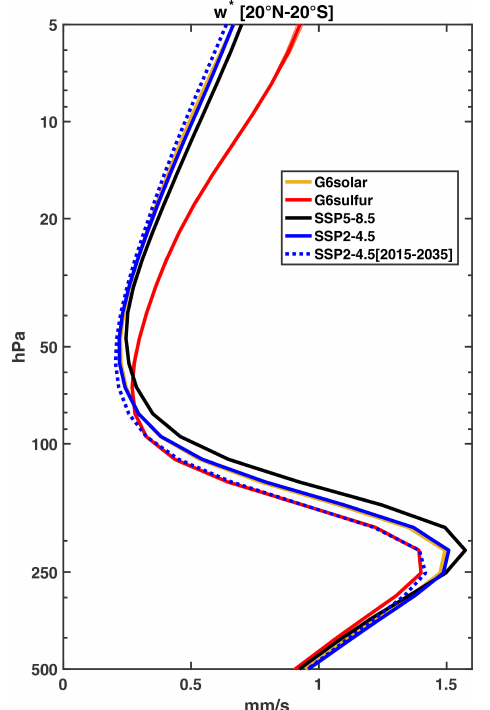
Figure 5. Zonally and annually averaged residual vertical velocity ( w ∗ ), averaged between 30 ◦ N and 30 ◦ S, for CESM2-WACCM6 for 2080–2100 and for different experiments (colored solid lines) and for 2015–2035 for SSP2-4.5 (blue dotted